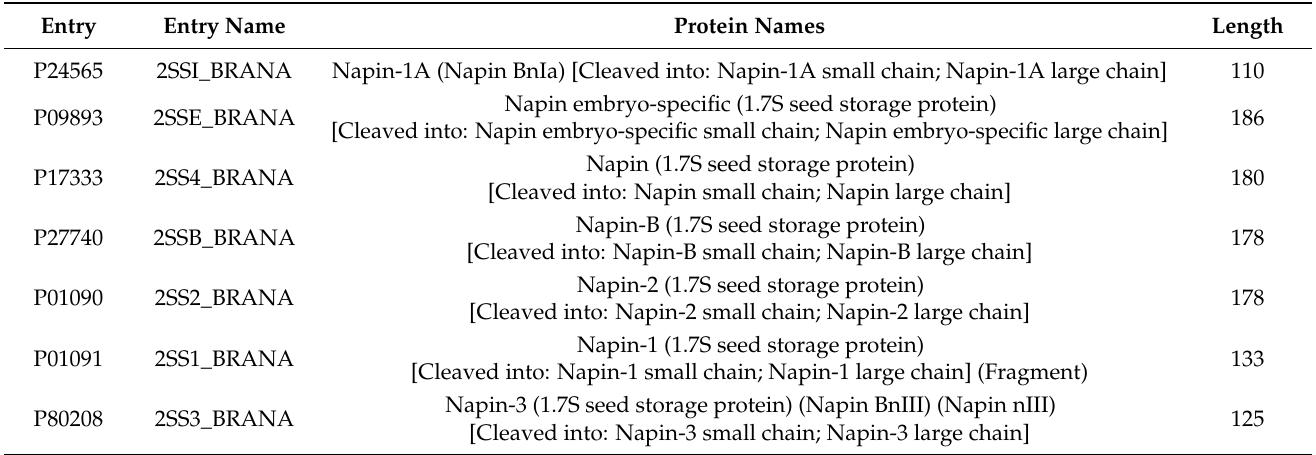
Table 5. Seven manually annotated entries for Brassica napus L. napin are listed in the Uniprot database (Source: https: //www.uniprot.org, accessed September 2021). Length is presented as amino acid